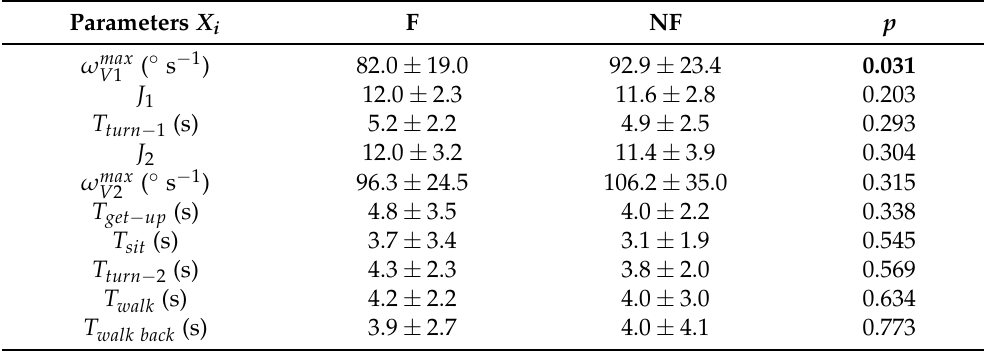
Table 3. Comparison of kinematic parameters between fallers (F) and non-fallers (NF) groups. Data are written under the form mean ± standard deviation. p -values for the comparison between F and NF groups are given in the last column; parameters are ordered by increasing p -values, with significant values in bold